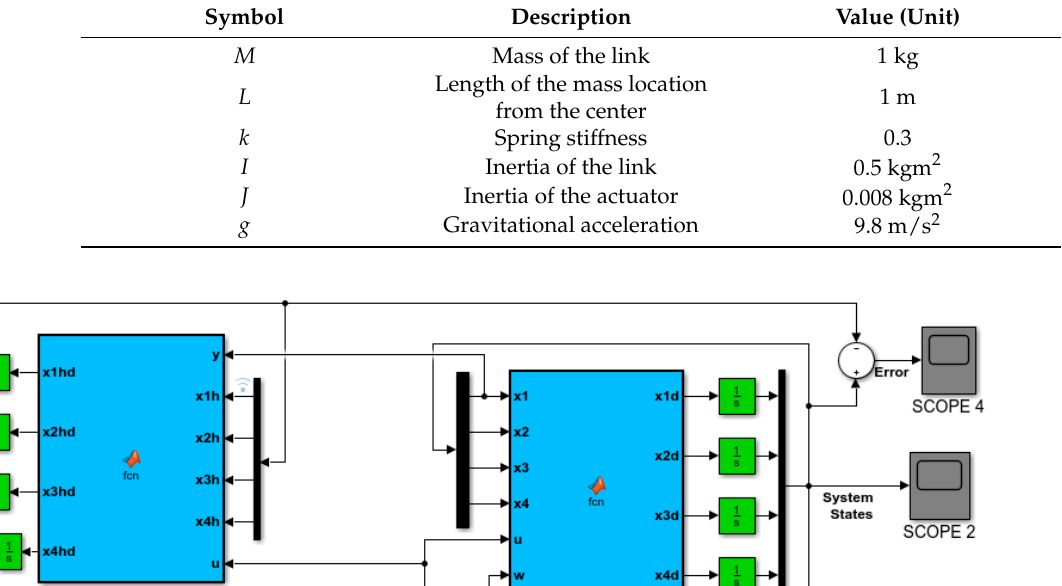
Figure 3. MATLAB/Simulink block diagram of the SFJRM with proposed output feedback controller in conjunction with HGO. Table 1. System parameters.